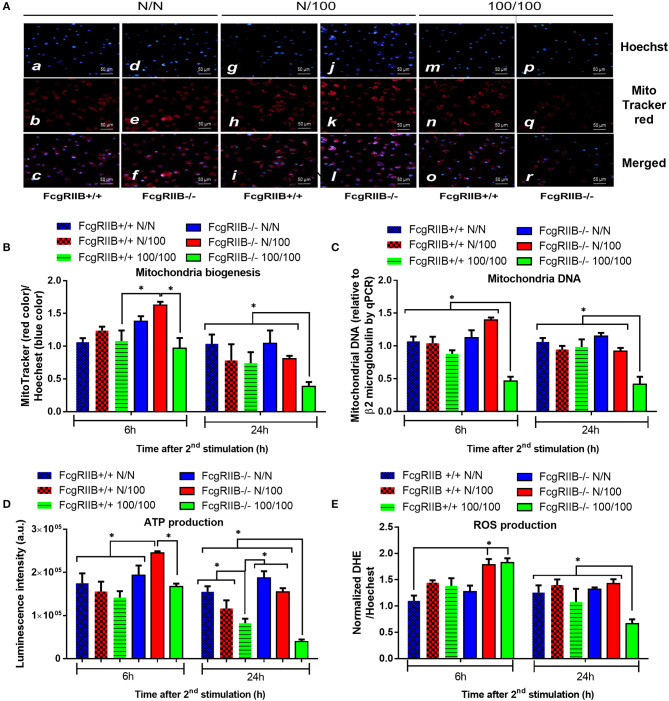
The evaluation of cell energy of wild-type (FcgRIIB+/+) macrophages and FcgRIIB–/– cells after single (N/100) or sequential (100/100) LPS stimulation vs. control (N/N) as determined by (1) mitochondrial assessment with Mitotracker Red as presented in representative figures from 6 h post-stimulation (A) and quantitative score (B), (2) semi-quantitative expression of mitochondrial DNA content (mtDNA) in relative to β2 microglobulin (β2M) gene by qRT-PCR (C), and (3) luminescence intensity of cellular ATP production (D) are demonstrated. Total cellular reactive oxygen species (ROS) as evaluated by Dihydroethidium (DHE) assay (E) are also shown (Independent triplicate experiments were performed; *p < 0.05).